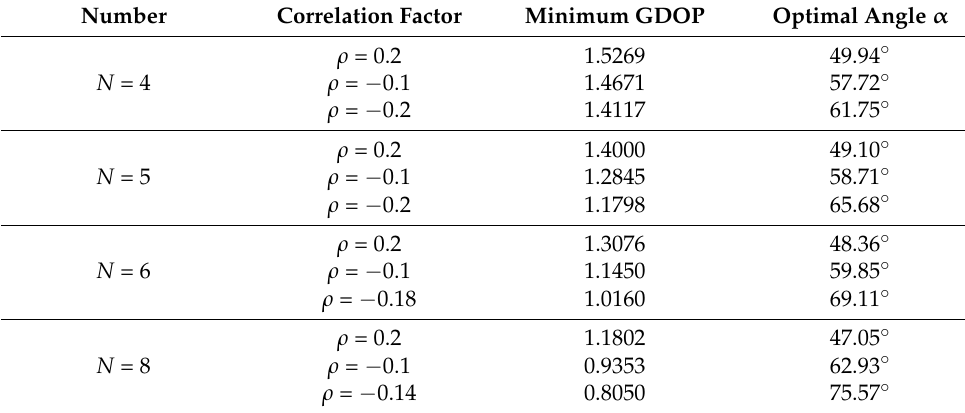
Table 2. The optimal angle α with different N and ρ